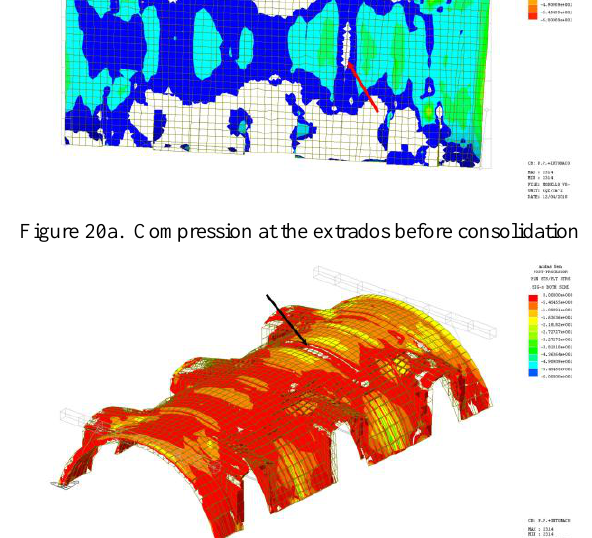
Figure 21a. Development of compression before consolidation